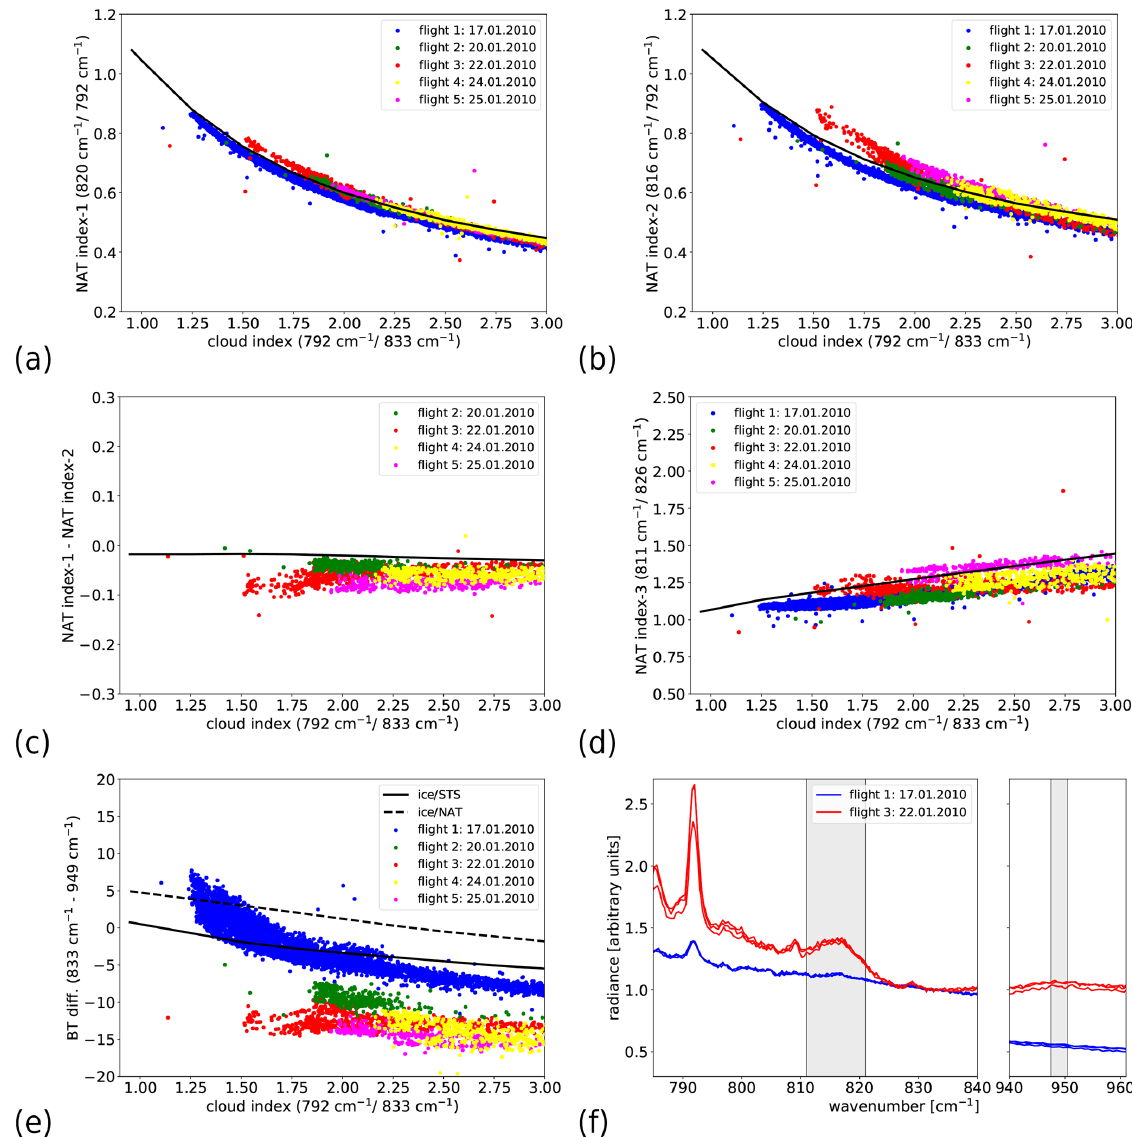
Figure 9. Correlations between the different NAT indices and the cloud index for the CRISTA-NF observations during RECON- CILE flights 1–5: (a) NAT index-1 (819–821cm − 1 )/(791–793cm − 1 ) (MW3/MW1); (b) NAT index-2 (815–817cm − 1 )/(791–793cm − 1 ) (MW4/MW1); (c) NAT index-1 – NAT index-2; (d) NAT index-3 (810–812cm − 1 )/(825–827cm − 1 ) (MW5/MW6). The black lines show the separation lines, which mark the upper envelope of the regions of STS and ice (in panels a , b , and d ) or the region of medium and large NAT (in panel c ). Simulation results for ice and STS are in shown in dark and light blue respectively. (e) Correlation between the BT difference (832–834cm − 1 ) – (947.5–950.5cm − 1 ) and the cloud index for the CRISTA-NF observations during RECONCILE flights 1–5. The black solid line shows the separation line between ice and STS, and the dashed line marks the separation between ice and NAT. (f) Example spectra from flight 1 and flight 3 for ice and NAT PSC respectively. The spectra have been scaled such that the radiance for all spectra equals one in the 832.0–834.0cm − 1 spectral window. The grey bars mark the region of the shifted NAT feature and the region used for the BTD around 949cm − 1